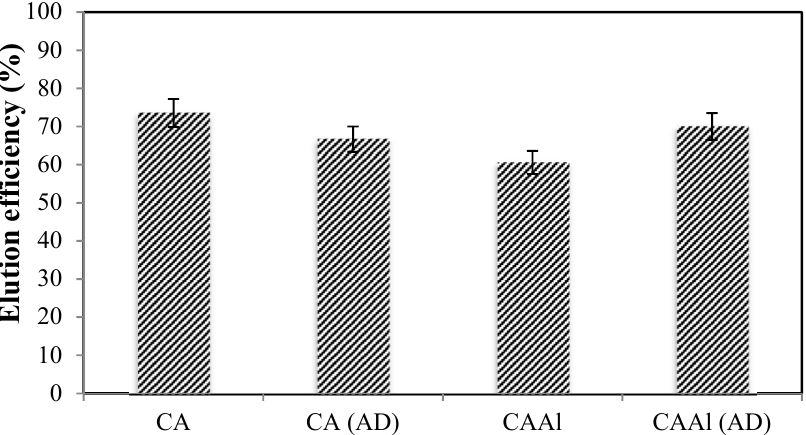
Figure 7. Elution of the sorbents using dilute solution of HCl as eluent. (AD: Air-dried sorbent, eluent: dilute HCl solution (distilled water at pH 3), [B]initial = 50 mg.L -1 , V = 100 mL).